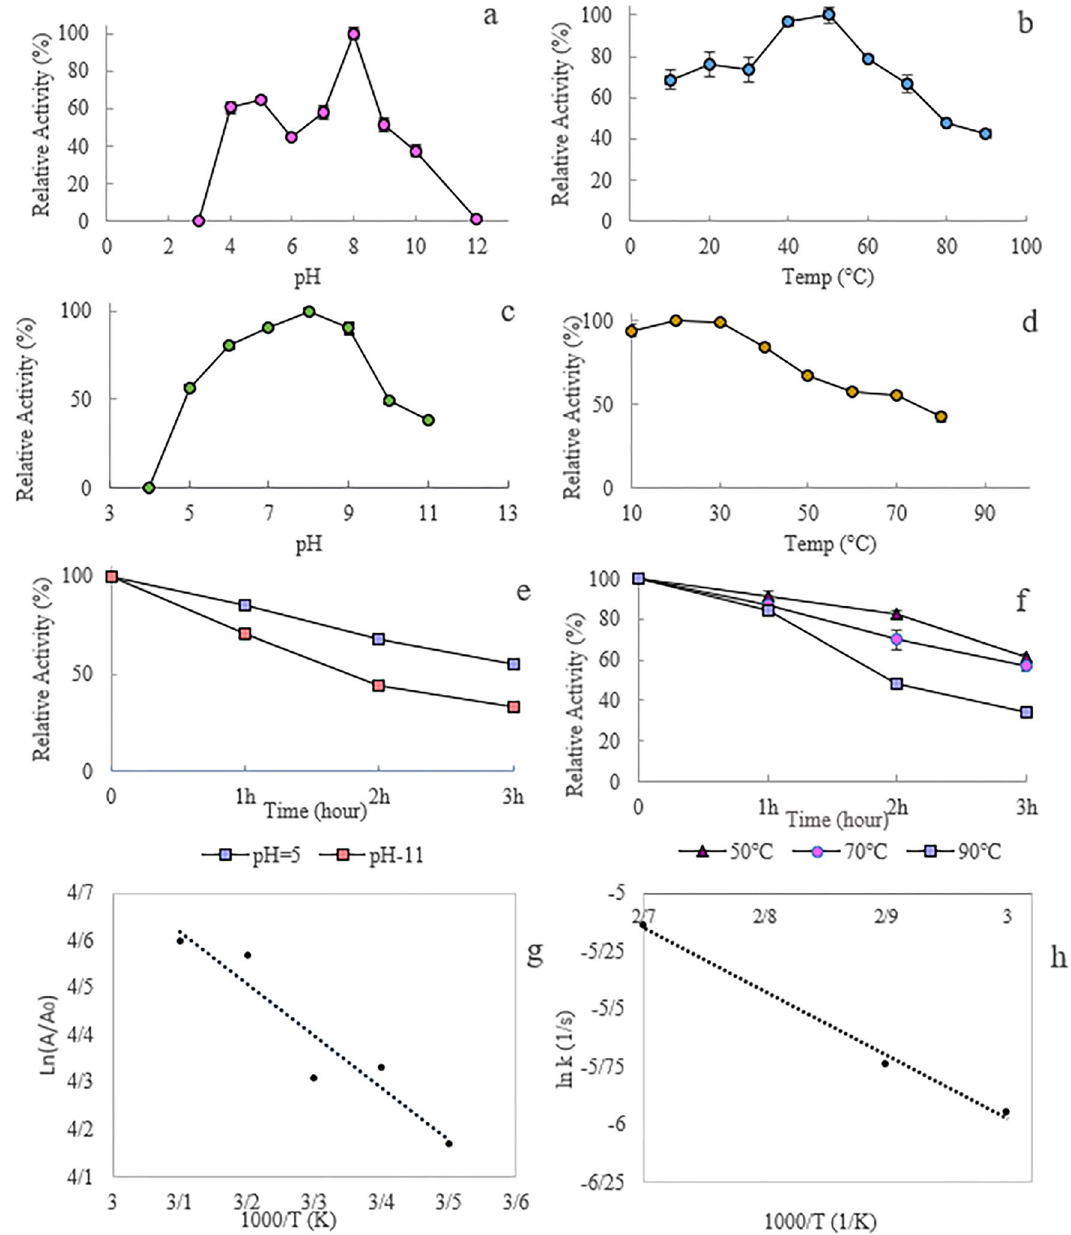
Figure 9. The effect of temperature and pH on rEla. ( a ) pH profile, the optimum pH for catalytic activity of the enzyme was 8. ( b ) Temperature profile, the optimum temperature of the enzyme activity was 50 °C. rEla showed more than 70% of residual activity at the temperature range of 20–60 °C ( c ) pH stability, ( d ) temperature stability, ( e ) pH stability at pH 5 and 11 in different times, ( f ) temperature stability at 50, 70 and 90 °C at different times. ( g ) Arrhenius plot for E a* and ( h ) E a# .